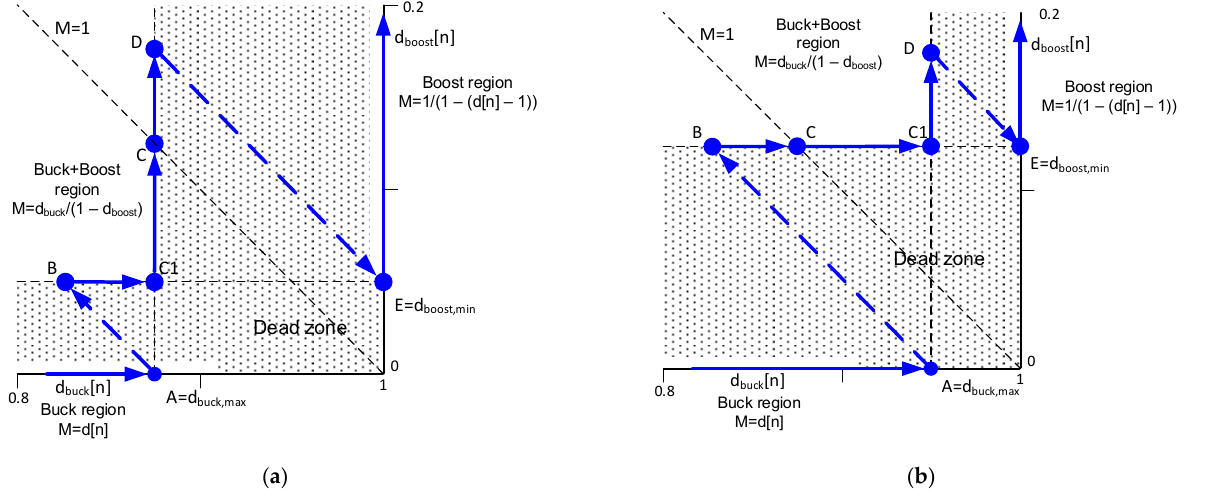
Figure 9. Trajectories defined by (d buck [n],d boost [n]) pairs to go from B to D and change from Buck to Boost mode using the Buck+Boost mode. When ( a ) d buck,max < 1 − d boost,min and ( b ) d buck,max > 1 − d boost,min .